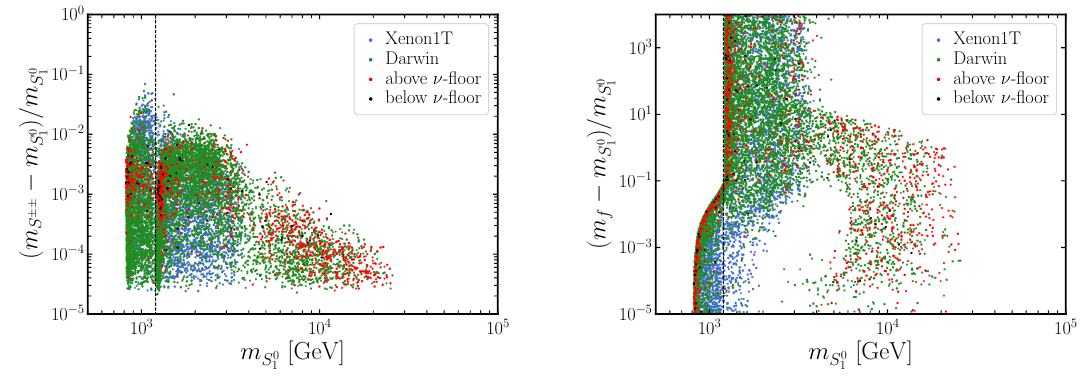
Figure 10 . Scan in the parameter space: relative mass splitting between the charge-2 scalar (left), the fermionic state (right) and the dark matter candidate. The color code is the same as in figure 5, as described in section 3.2.